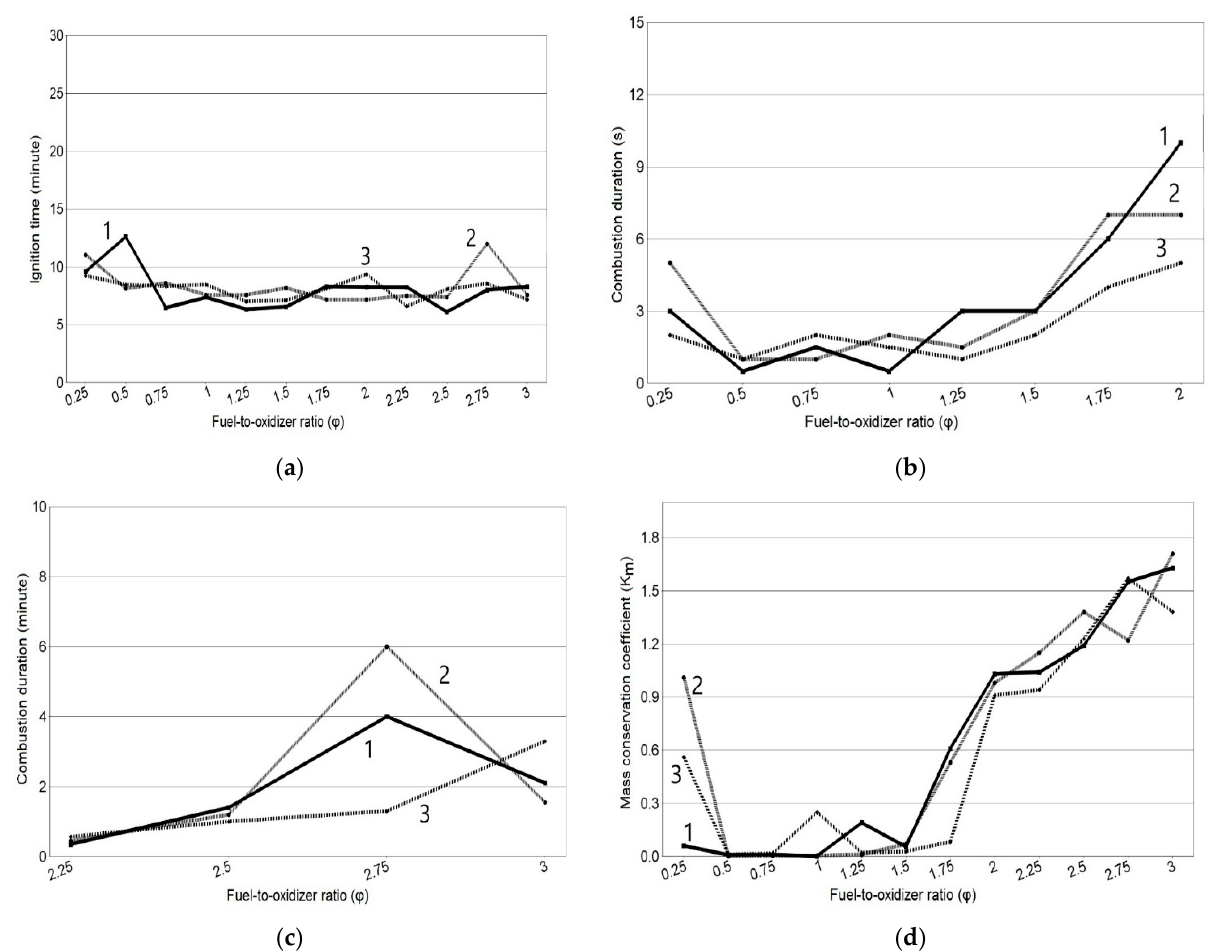
Figure 1. Dependence of the combustion characteristics for the SCS process on the φ parameter: ( a ) t ign ( φ ); ( b ) t comb ( φ ) from φ = 0.25 to φ = 2; ( c ) t comb ( φ ) from φ = 2.25 to φ = 3; ( d ) K m ( φ ).